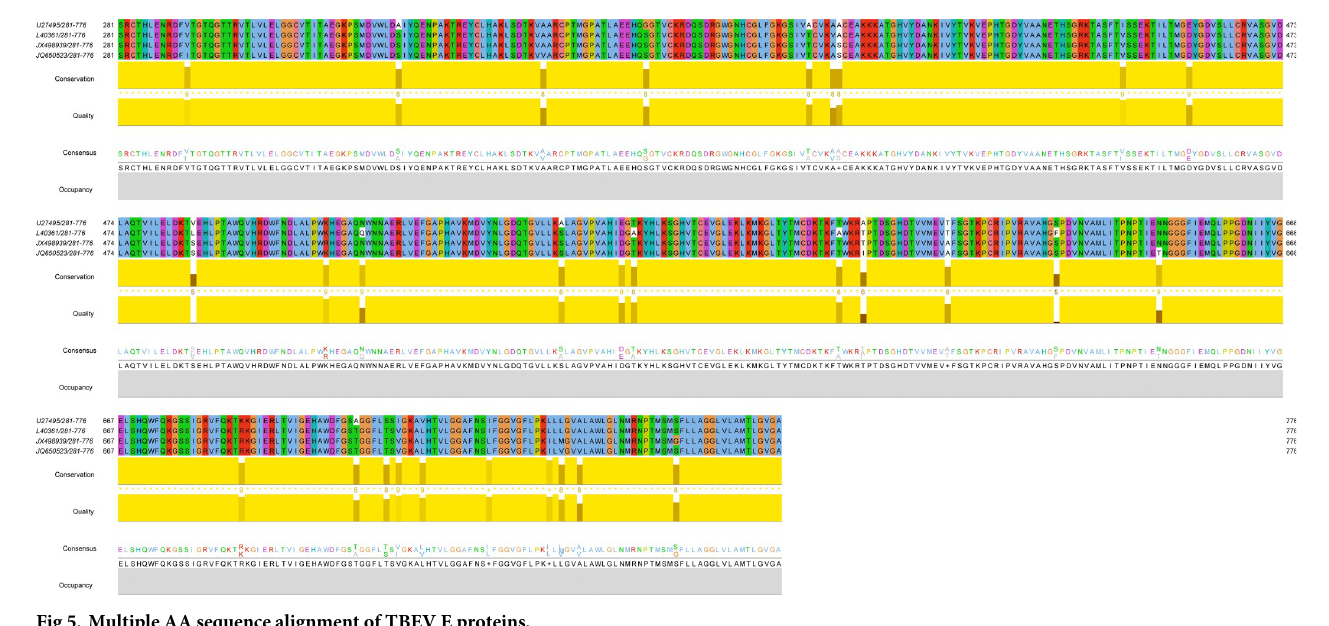
Fig 5. Multiple AA sequence alignment of TBEV E